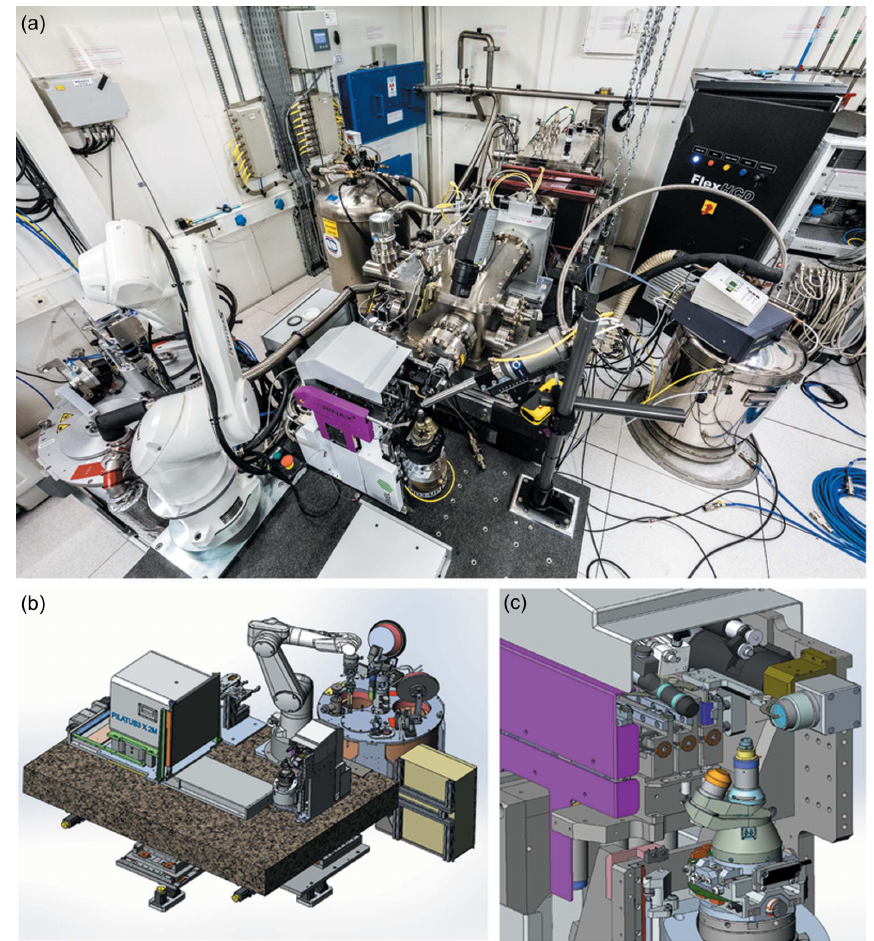
Figure 4 ID23-2 sample environment. ( a ) Photograph of the sample environment (Stef Cande, ESRF), ( b ) MD3Up, detector and FLEX-HCD, ( c ) close-up of